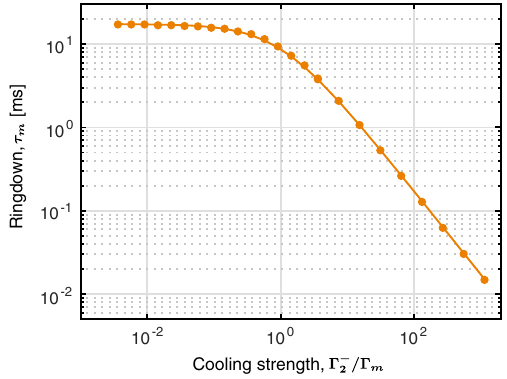
FIG. 5. Mechanical ringdown time. We measure the mechanical ringdown time τ as a function of the strength of a cooling drive m on the control cavity, at a frequency ω − 2 ¼ ω 2 − Ω light and damping the mechanical oscillator at the rate Γ − 2 . The solid line is the theoretical prediction from the total damping, Γ ¼ Γ þ Γ − 2 . We measure an intrinsic mechanical ringdown m tot ¼ 17 . 3 ms, corresponding to a relaxation rate time of τ m Γ ¼ 1 = τ ¼ 2 π × 9 . 2 m m